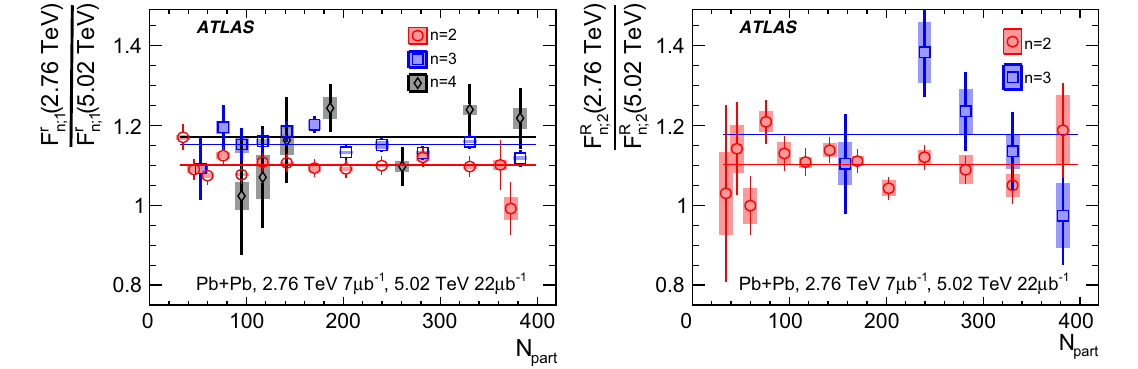
uncertainties given by Table 5. The error bars and shaded boxes are values (left panel) and n ; 1 statistical and systematic uncertainties, respectively